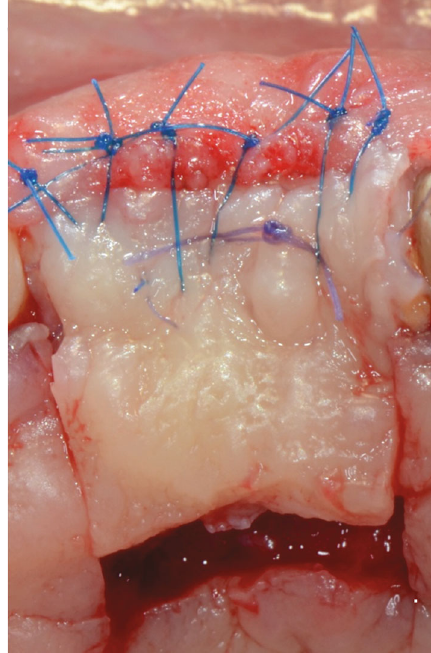
Figure 18: Primary intention closure with palatal island fl ap.